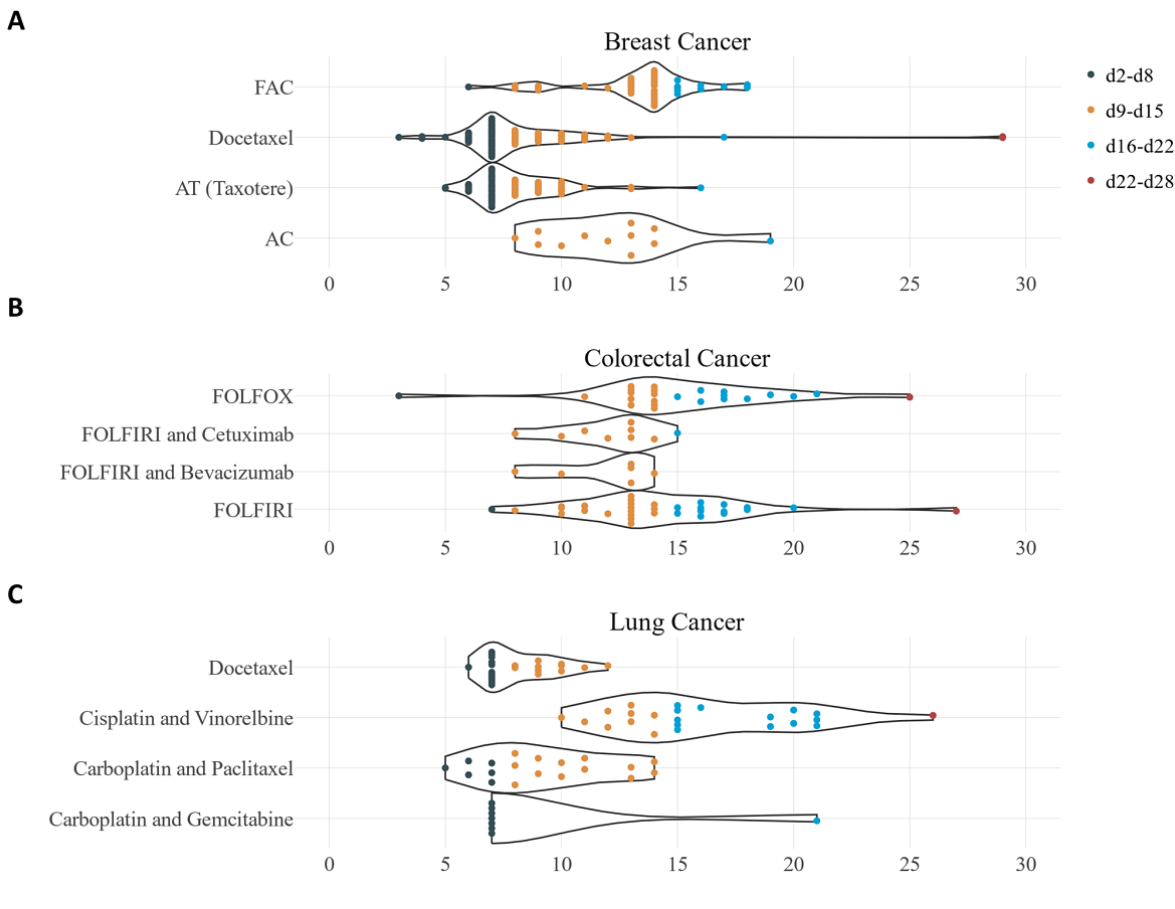
Figure 7. Trends in neutropenia onset time according to regimen. Time of onset of chemotherapy-induced (febrile) neutropenia event after the first exposure to chemotherapy among patients with (A) breast cancer, (B) colorectal cancer, and (C) lung cancer at the Ajou University School of Medicine. Each dot represents the neutropenia event of a distinct patient. The events are categorized in a 7-day range. The violin plot represents the trends in the frequency on each day from chemotherapy exposure. AC: doxorubicin and cyclophosphamide; FAC: fluorouracil, doxorubicin, and